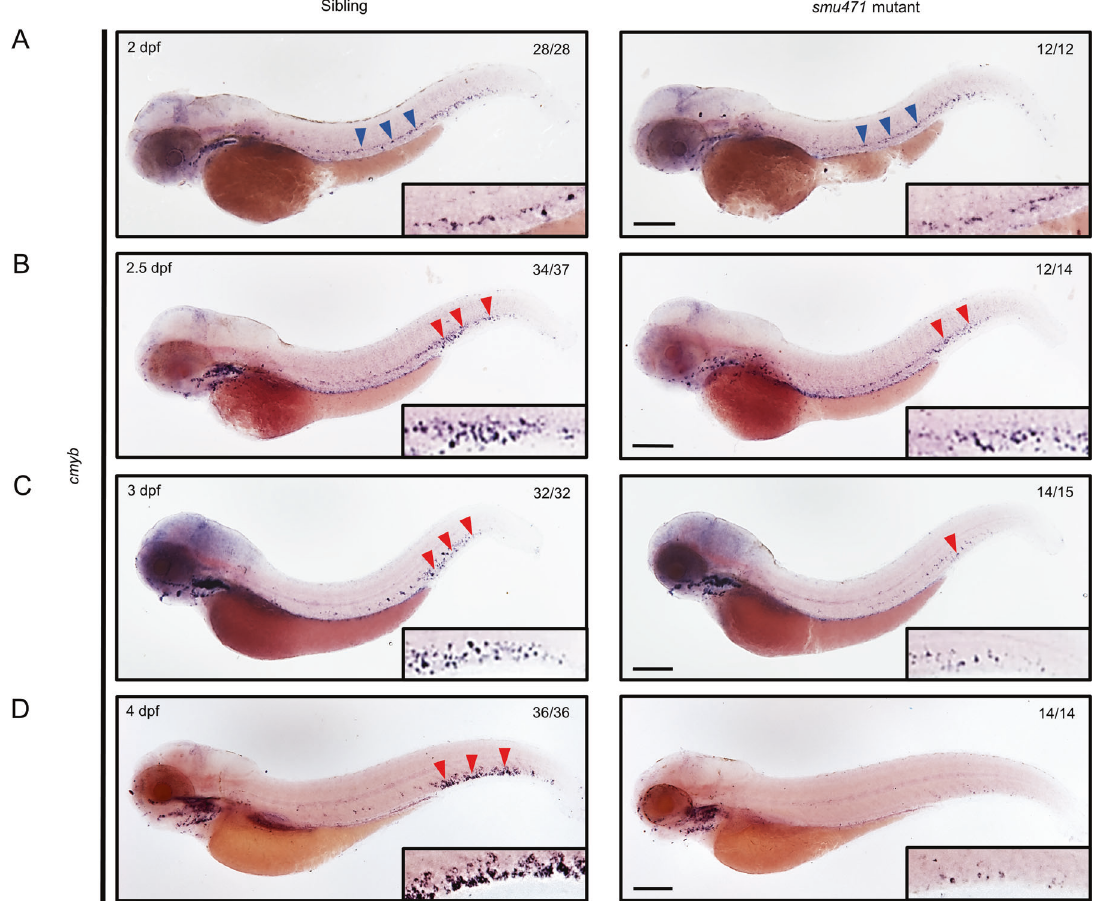
Fig. 1 Decreased HSPCs in the CHT region of zebra fi sh smu471 mutants. A – D cmyb WISH identi fi ed HSPCs from 2 to 4 dpf in smu471 mutants (right) compared with their siblings (left). A cmyb + signals were not altered at 2 dpf in the VDA region (blue arrowheads indicate signals in the region). B In the CHT region, cmyb + signals were decreased slightly at 2.5 dpf in smu471 mutants (red arrowheads indicate signals in the region). C , D Severely decreased cmyb + signals in the CHT region at 3 dpf ( C ) with a further reduction at 4 dpf ( D ) in smu471 mutants. The boxed regions in the lower right corner are magni fi cations. Scale bars: 200